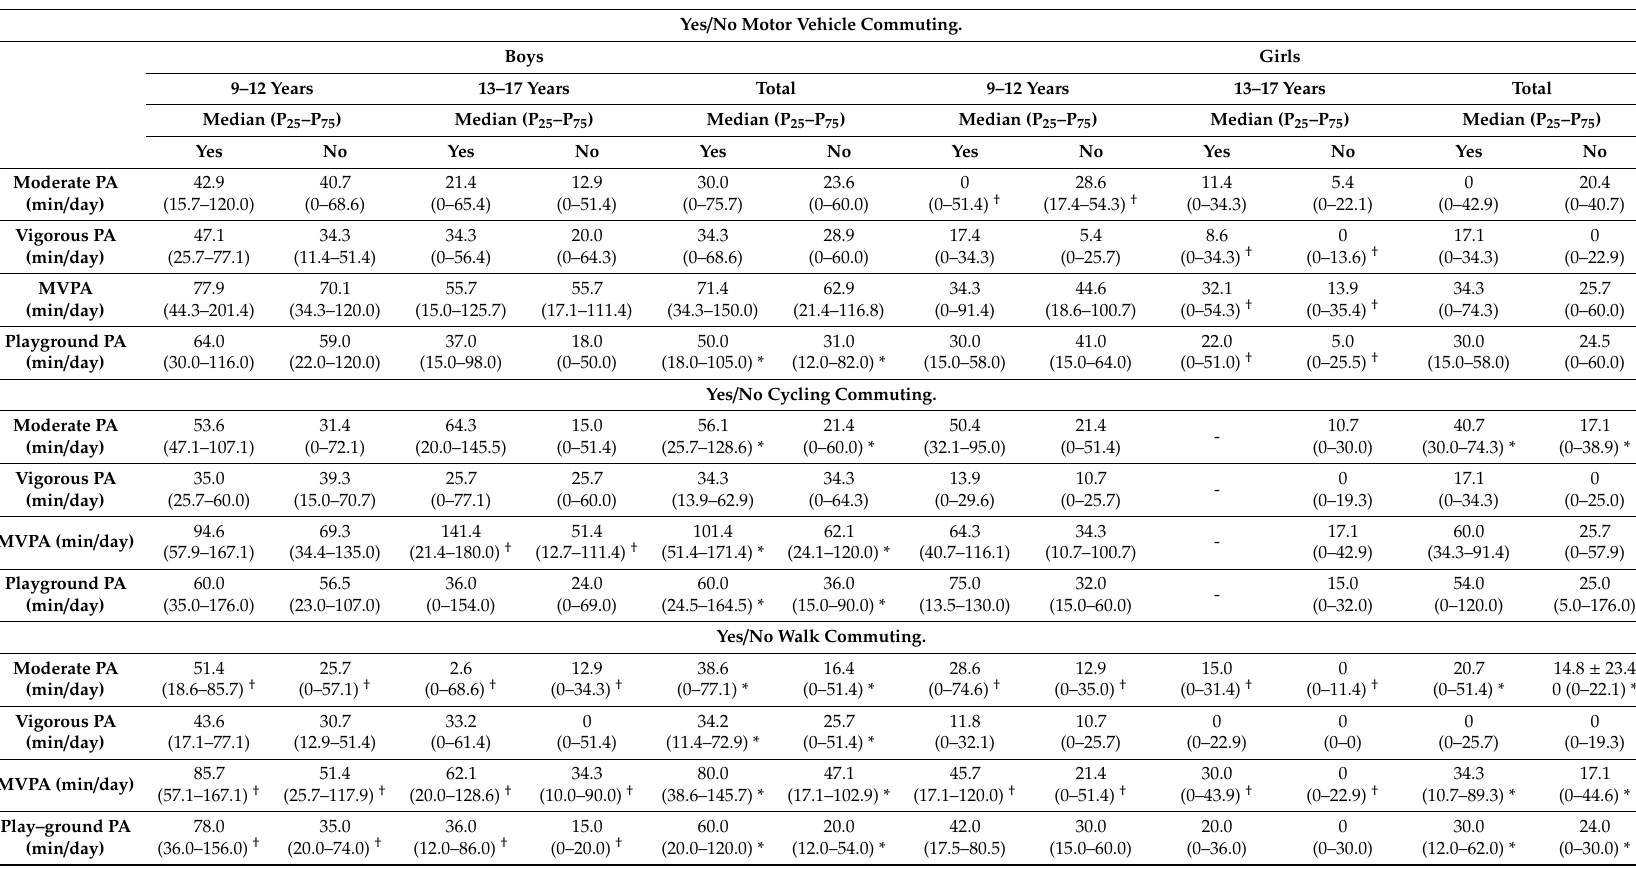
Table 2. Descriptive characteristics between PA levels divided by sex, age groups and commuting to / from school (motor vehicle, cycle, and walk). Yes / No Motor Vehicle